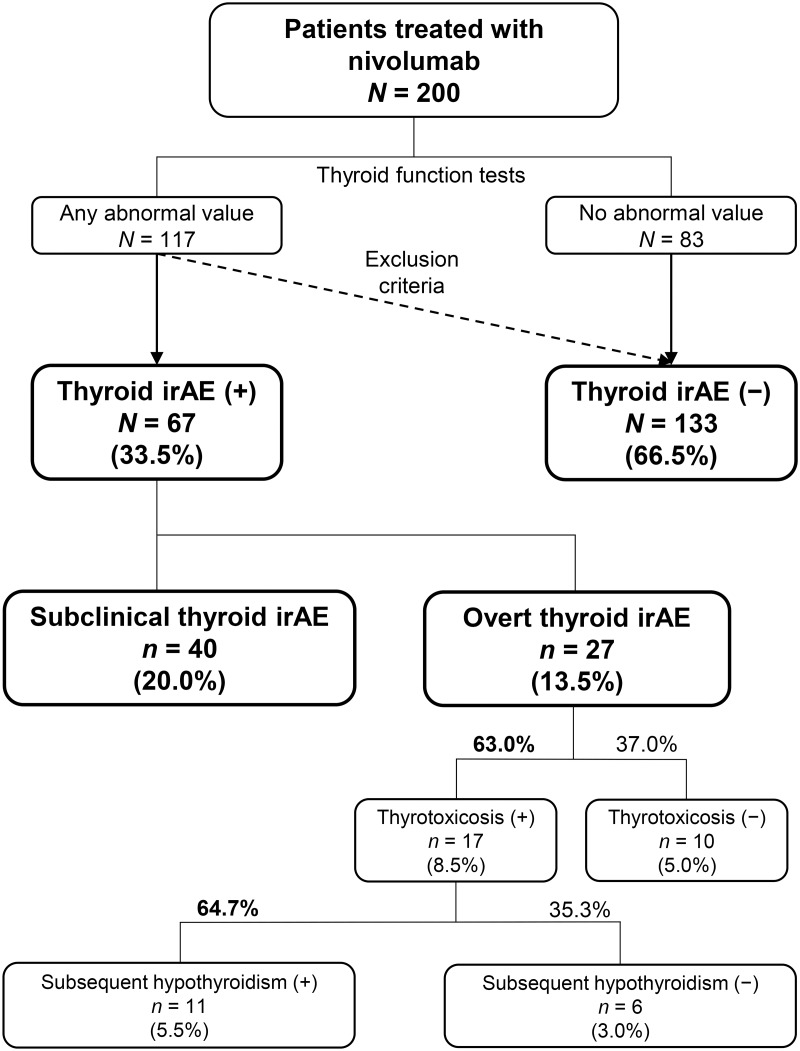
A flowchart for determination of immune-related adverse events involving the thyroid gland (thyroid irAEs).Determination and classifications were based on data of thyroid function tests.